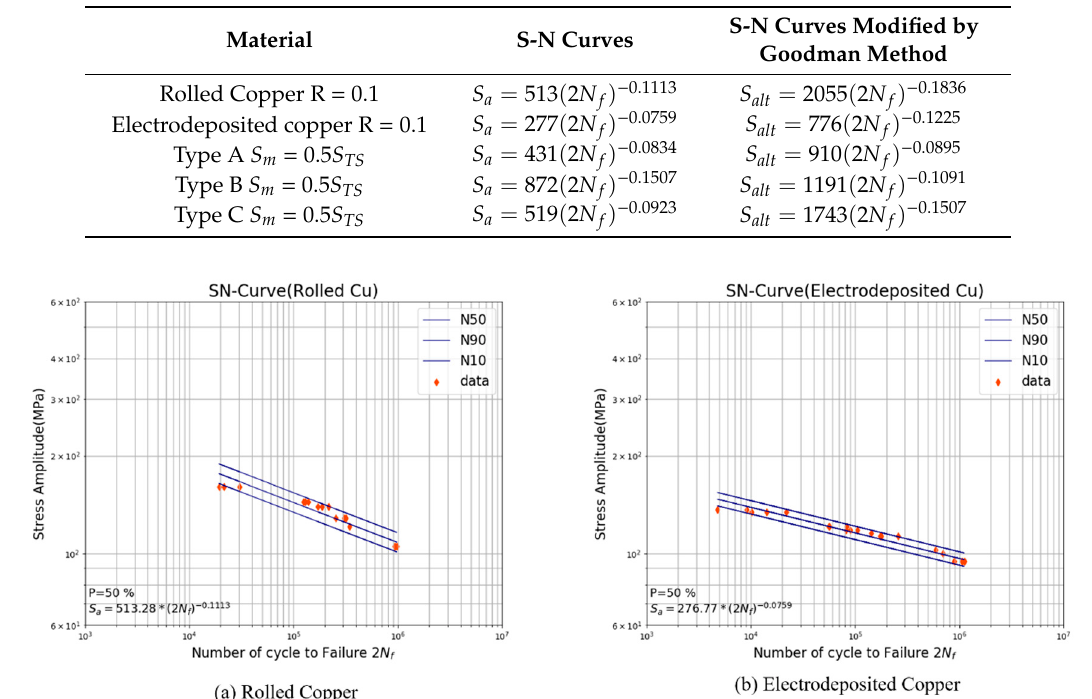
Table 2. Comparison of stress-life equation according to the process using Goodman method.